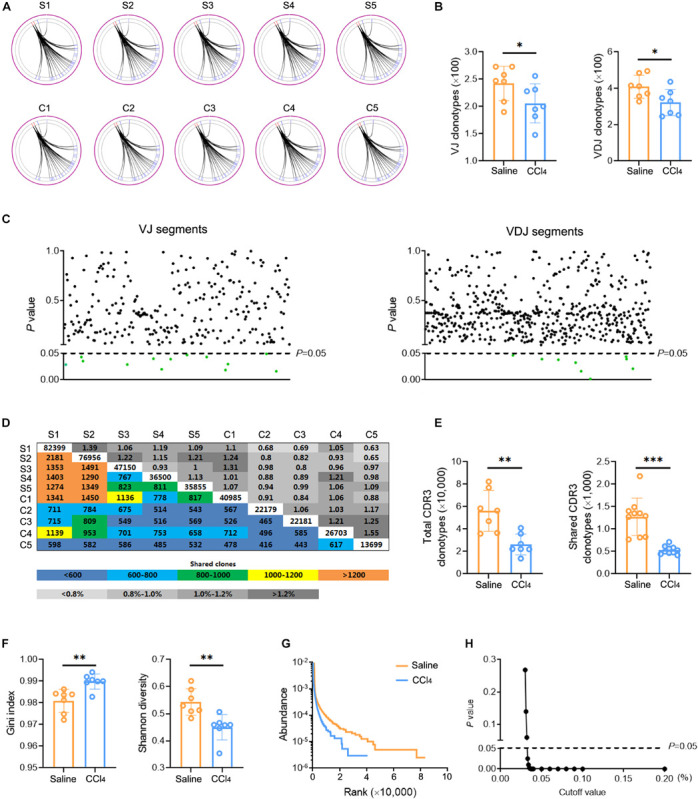
Fibrogenesis diminishes intrahepatic TCR diversity. WT mice were treated three times weekly with CCl4 or 0.9% saline for 8 weeks. TCR IR-seq data from intrahepatic isolated immune cells were evaluated (N = 5–7). (A) Circle diagram showing the composition of VJ segments. (B) Quantification of the composition of VJ segments (left) and VDJ segments (right). (C) The frequencies of VJ segments (left) and VDJ segments (right) that had significant differences (P < 0.05). Green color indicated downregulation. (D) Quantification (colored plots) and frequency (gray plots) of TCR CDR3 AA clones between two groups. Uncolored plots indicate the total clones per sample. (E) The total (left) and shared (right) CDR3 AA clones in each group. (F) The Gini index (left) and Shannon diversity (right) CDR3 AA clones in each group. (G) Rank-abundance showing CDR3 AA richness and evenness. (H) Comparison of clone frequencies for intrahepatic TCR CDR3 AA (dotted line indicates P = 0.05). The cut-off value depends on the clonal frequency exceeding a certain threshold. *P < 0.05; **P < 0.01; ***P < 0.001.